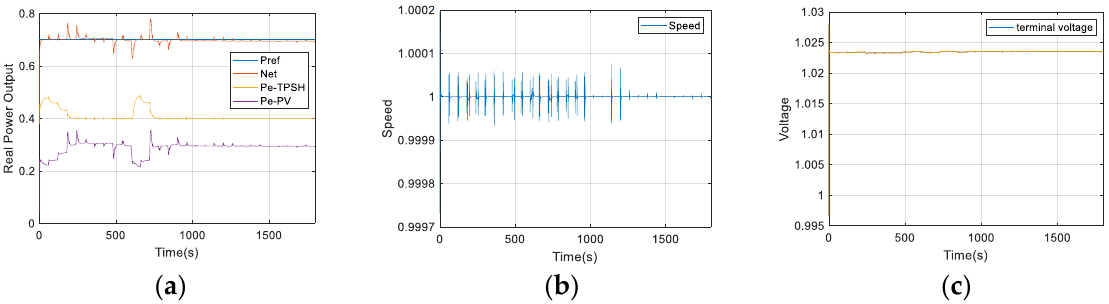
Figure 11. PV firming from t = 610 min to t = 640 min showing ( a ) power output from PV and TPSH during dynamic simulation to meet set-point ( b ) speed and ( c ) terminal voltage during simulation.